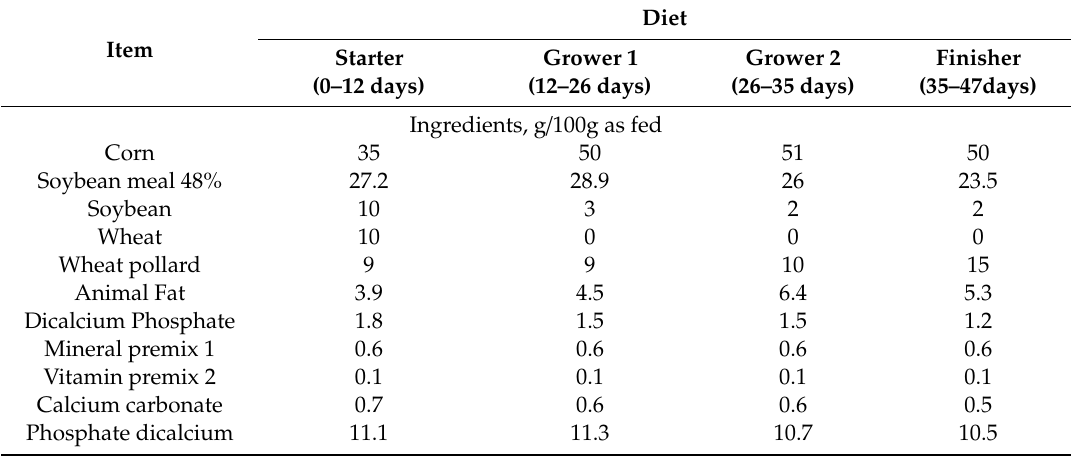
Table 1. Ingredients and chemical composition of the experimental